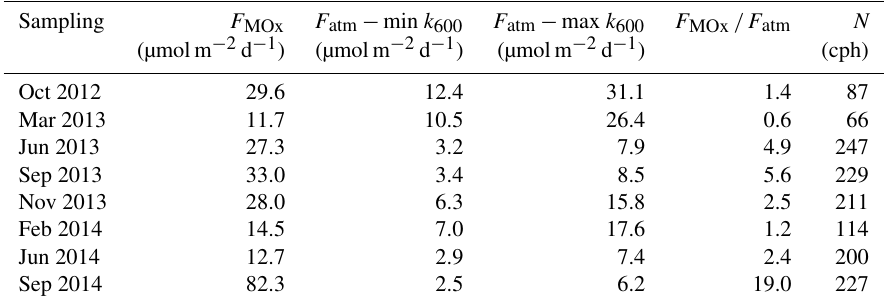
Table 2. Integrated methane oxidation rates ( F MOx ) and methane flux into the atmosphere ( F atm ) in comparison to stratification (indicated by the buoyancy frequency N). F atm was calculated with a min and max k 600 -value. N is given as the average N for 10–20mb.s.l. A water column with N values >120 is considered